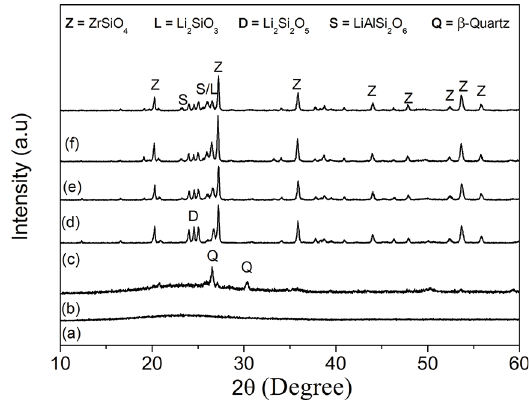
Figure 3. X-ray diffraction patterns of the LZS parent glass (a), LZS glass-ceramic sintered by fast fired at 800 ºC (b), LZS glass-ceramic sintered by fast fired at 900 ºC (c), and LZS with different alumina additions (c, d, and e) fast fired at 900 ºC/30 min. (Z) zirconium silicate, ZrSiO ; (D) lithium disilicate, Li Si O ; (Q) β-quartz; (S) 4 2 2 5 β-spodumene, LiAlSi O and (L) lithium metasilicate, Li SiO 2 6 2 3